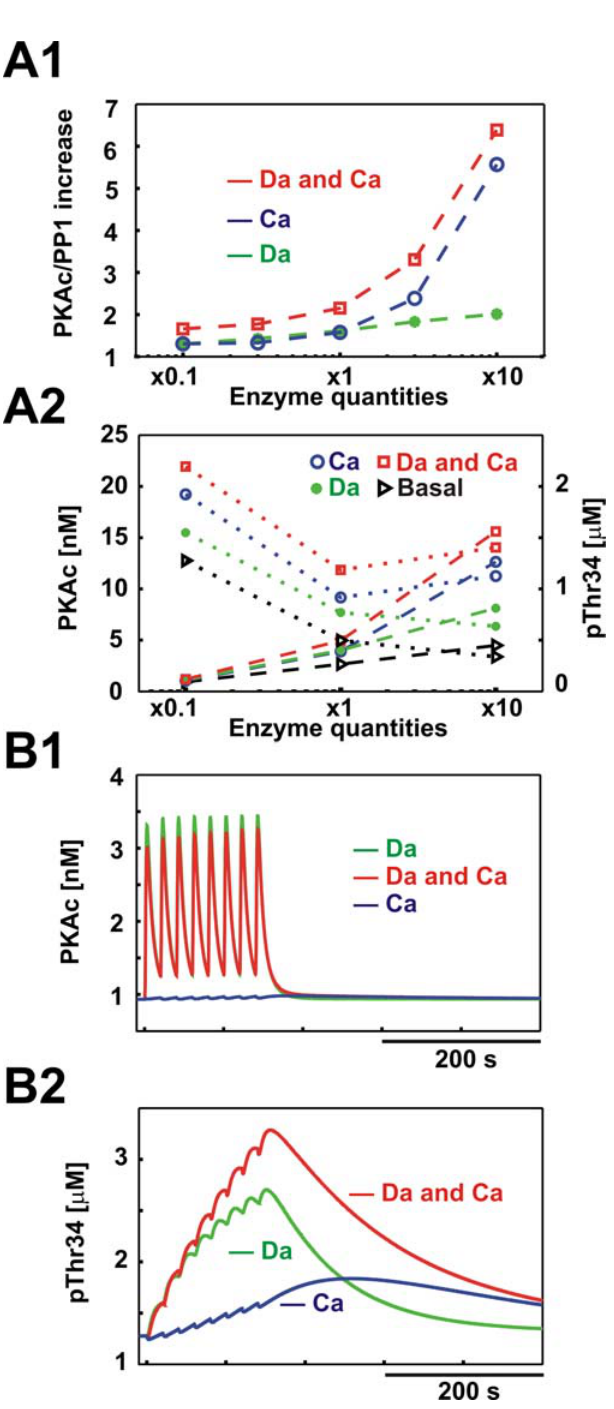
Figure 9. Role of Altered Enzyme Quantities on the Integration Properties of DARPP-32 (A) Total concentrations of PKA, PP2B, PP2A, and cdk5 all are varied together between 0.1–10 3 the control level. (A1) Independent of this variation, pairing of calcium and dopamine (red, squares) is more effective than either input alone (green dots or blue circles). (A2) The basal levels of PKAc (black dashed line, triangles) as well as phosphoThr34 (black dotted line, triangles) vary with enzyme quantity. A decrease in enzyme quantity produces a decrease in the change of PKAc during stimulation (dashed line) and an increase in the phosphoThr34 levels (dotted line). Nonetheless, in all cases a simultaneous calcium and dopamine input is most effective in elevating both PKAc and